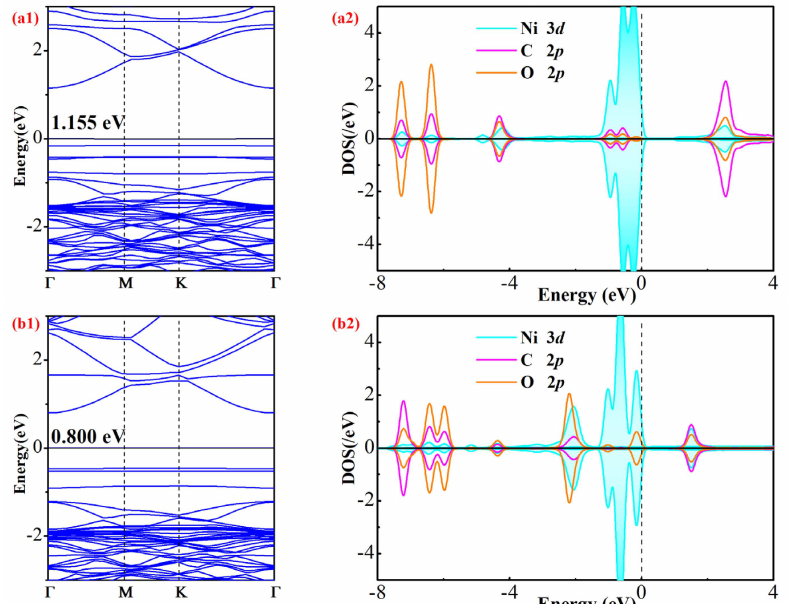
Figure 4. BS and atomic DOS of ( a1 , a2 ) CO system and ( b1 , b2 ) HCHO system. In BS, the black value is the bandgap while in DOS the Fermi level is set as